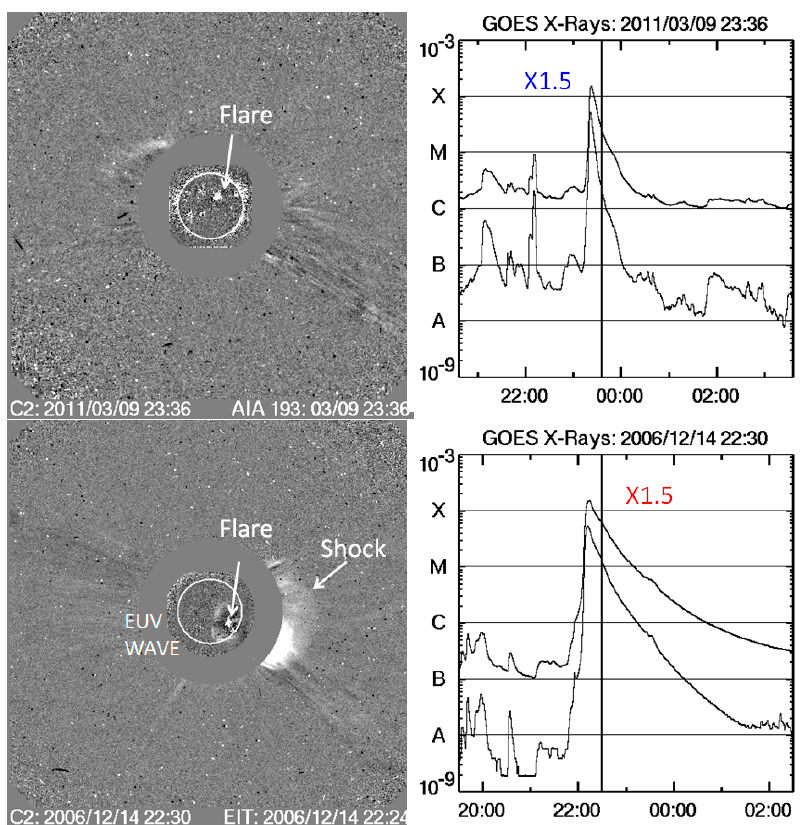
Figure 8. A confined ( top ) and an eruptive flare ( bottom ). The confined flare is not associated with mass motion—just electromagnetic emission (in EUV image taken by SDO/AIA). The eruptive flare has surrounding disturbances in EUV, including (from SOHO/EIT) a CME and its shock (from SOHO/LASCO). The GOES soft X-ray light curves in the right side panels show that flare intensities are very similar (X1.5). The vertical dark lines mark the time when the images on the left side panels were obtained.